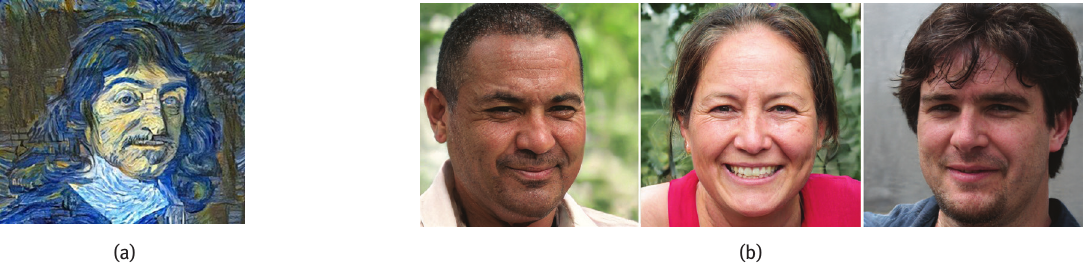
flow, either by rule-based or learning-based operations. For example, this is achieved in in Generative Adversarial Networks, where one network generates images, trying to fool another network that is trained to discriminate self-generated images from real images.58